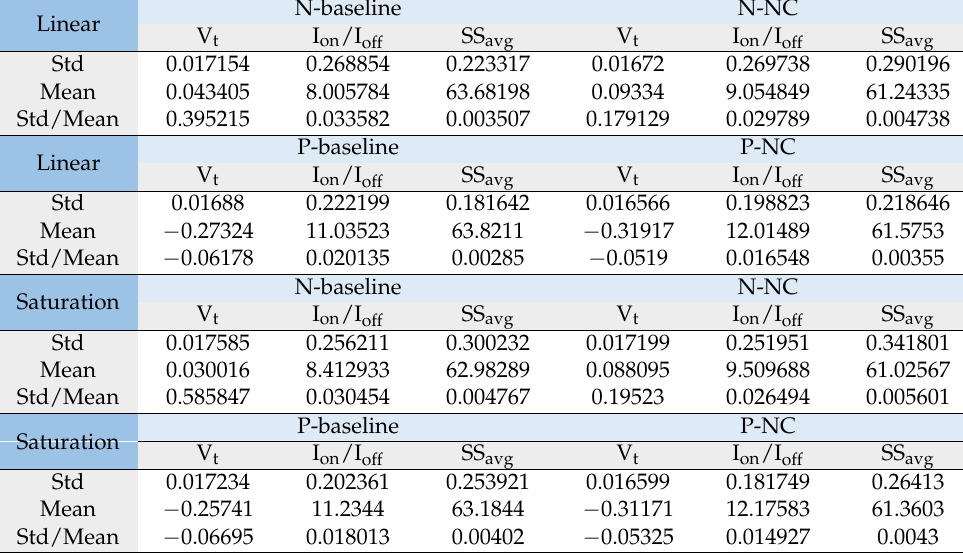
Figure 3. Simulated I DS -V GS curves ( a ) for n-type JL-NWFET (JL) and ( b ) for n-type NC-JL-NWFET (NC-JL) with WFV. I DS -V GS curves ( c ) for p-type JL-NWFET (JL) and for ( d ) p-type NC-JL-NWFET (NC-JL) with WFV. The dotted line indicates the nominal I DS -V GS for JL-NWFET and NC-JL-NWFET. Table 2. Variation parameters of n-/p-type JL-NWFET and NC-JL-NWFET in linear and saturation mode with work function variation.